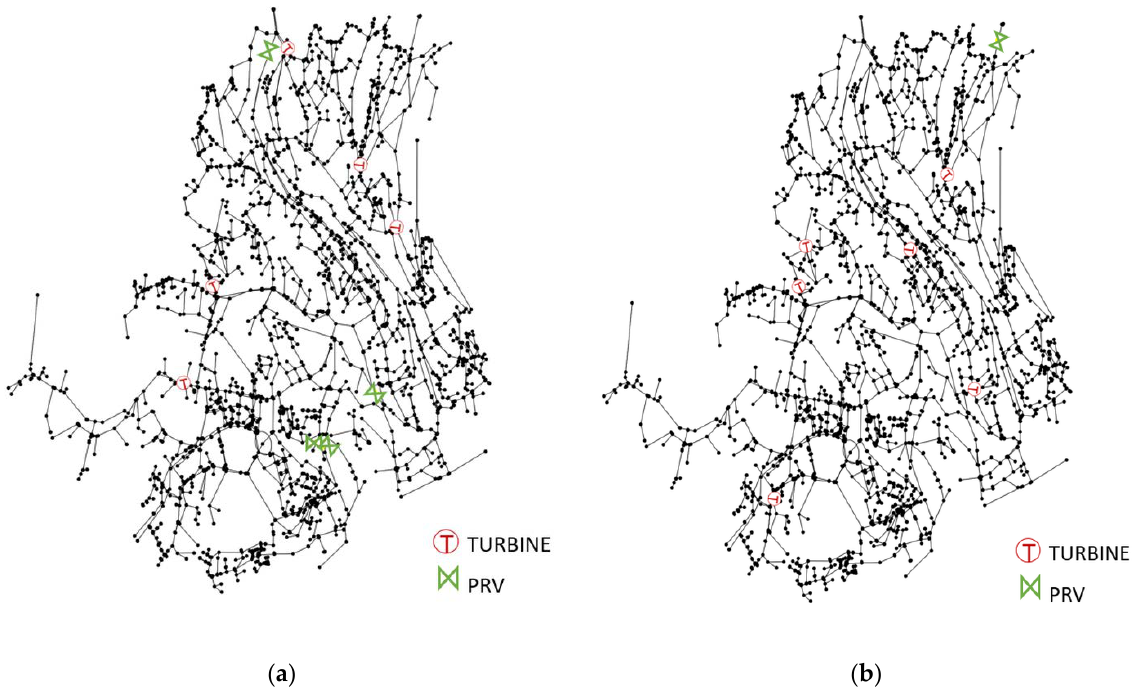
Figure 14. Device positions within the case study WDN according to the results in (I) ( a ) and (II) ( b ). The turbines are installed in both the cases in the middle region of the network, whereas the valves are installed in the peripheral area, where the water saving potential is large but the recoverable energy is